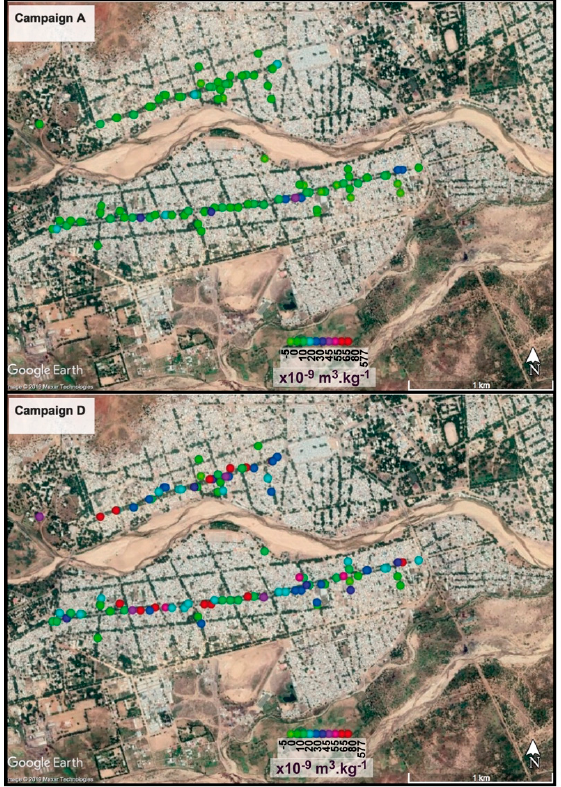
Figure 2. Mass magnetic susceptibility obtained on leaves during campaigns A (mid-August) and D (end-December).